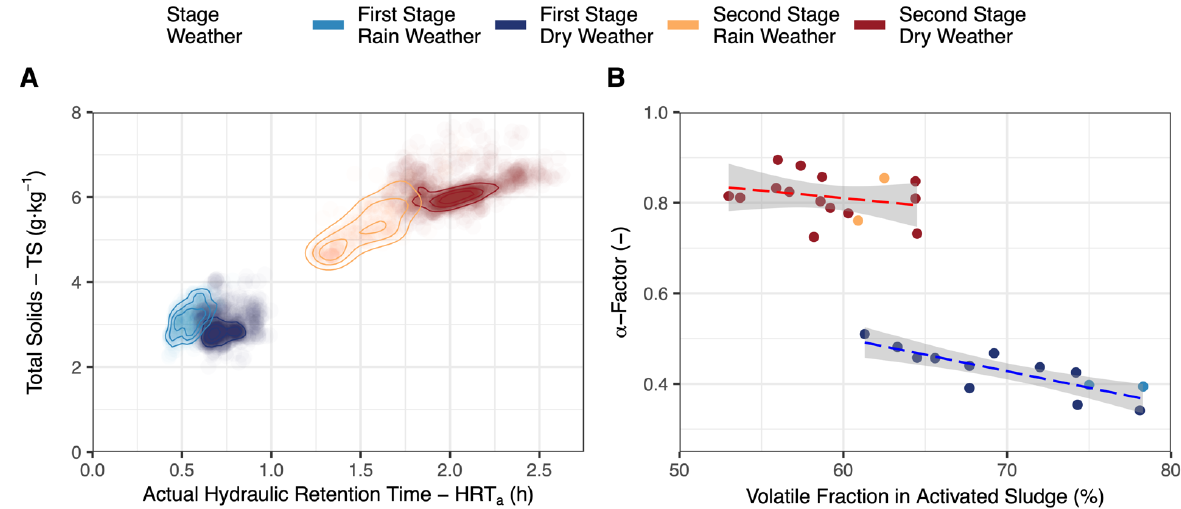
Figure 5. TS for HRT a ( A ) and α -factor for volatile fraction in activated sludge as daily mean ( B ), grouped for both treatment stages of a two-stage WWTP and weather conditions.